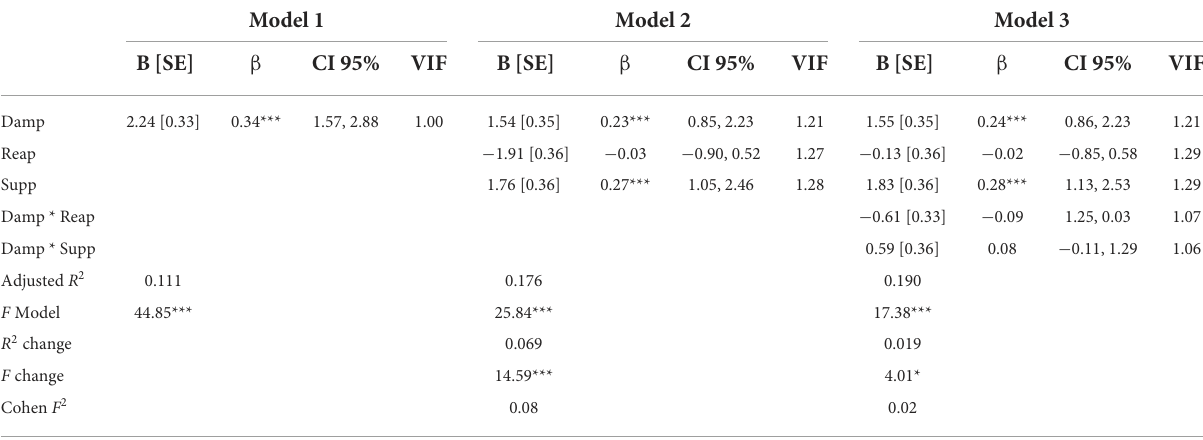
TABLE 5 Moderation model for the association between dampening and insomnia